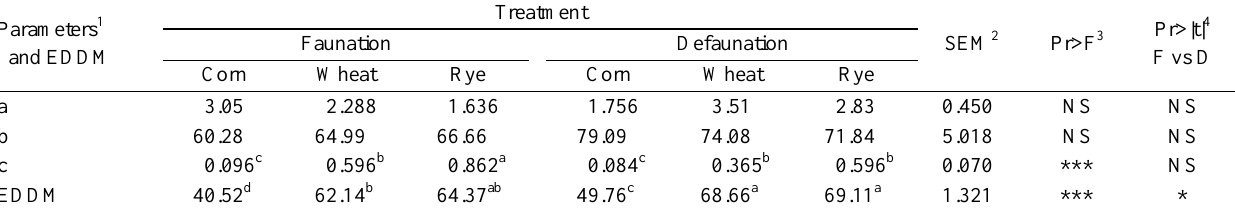
1 a = Intercept representing rapidly soluble fraction in the rumen; b = Fraction of degradable at time infinity; c = Rate constant of disappearance of